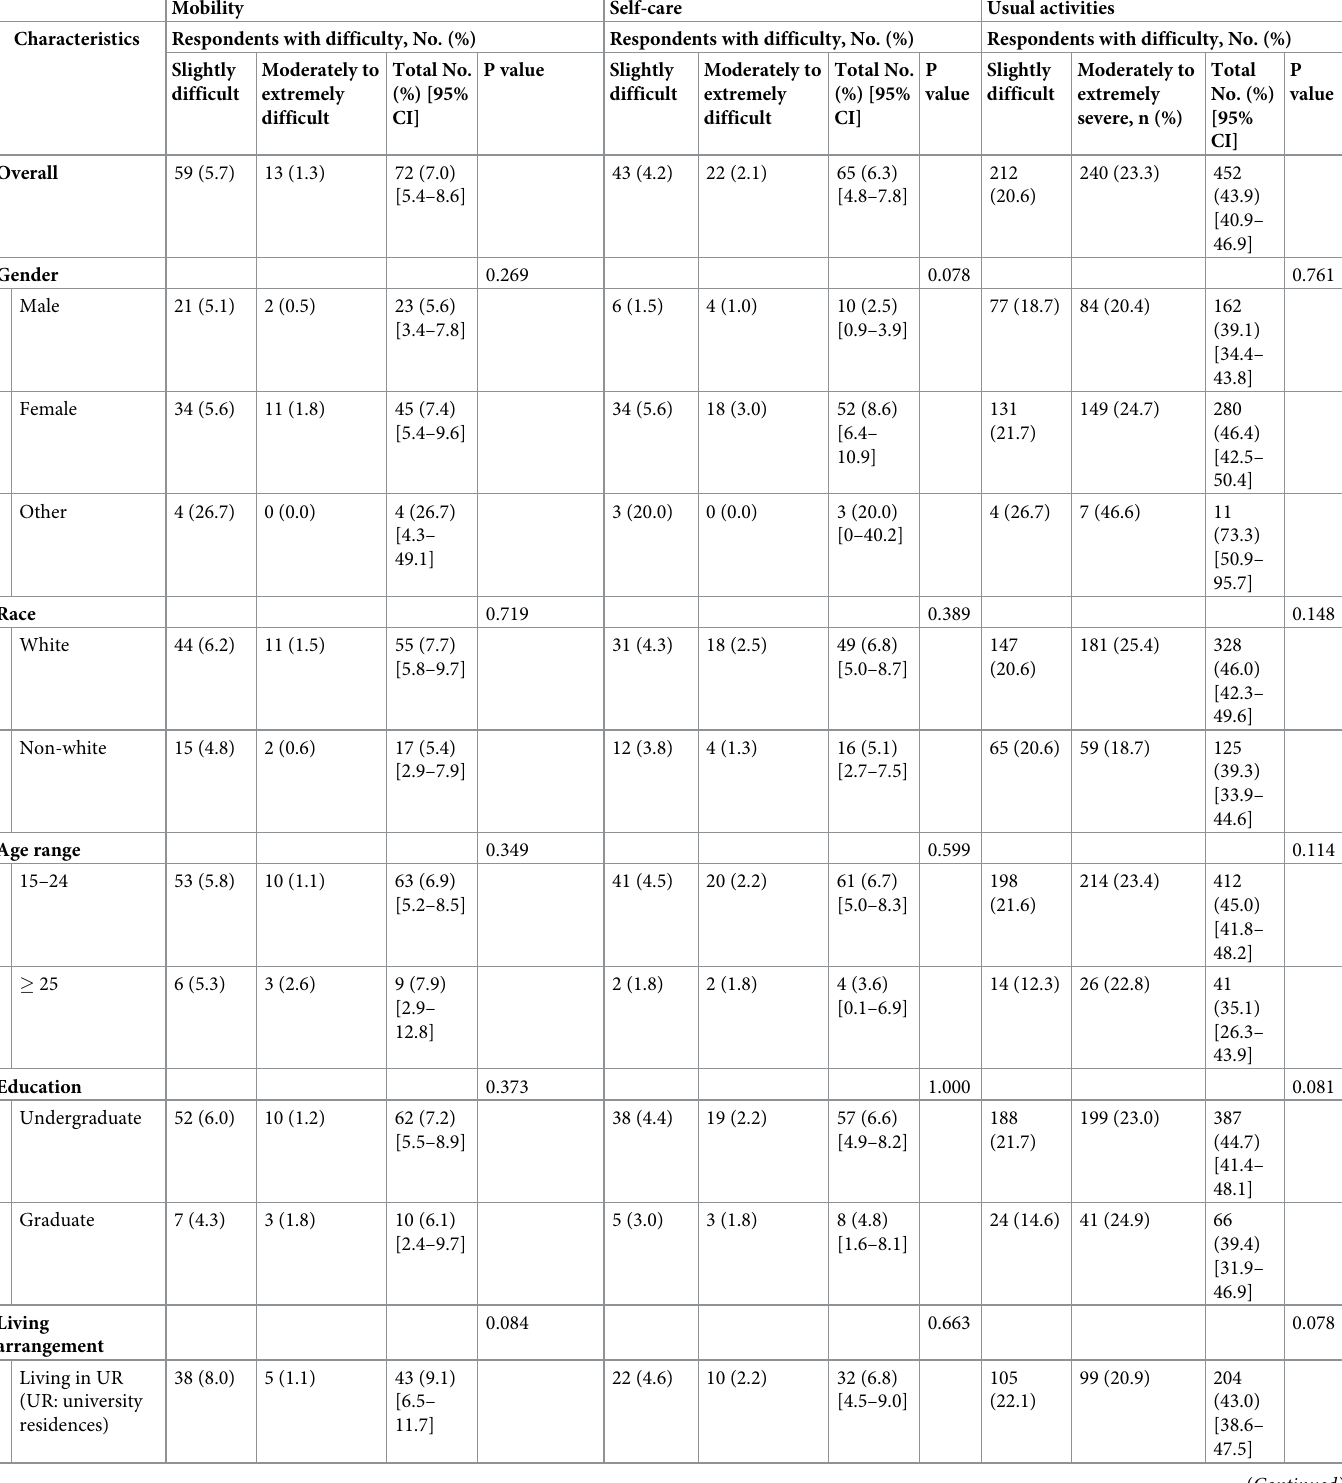
Table 3. Severity of mobility, self-care, usual activities, pain/discomfort, and anxiety/depression symptoms (EQ-5D) stratified by survey respondent